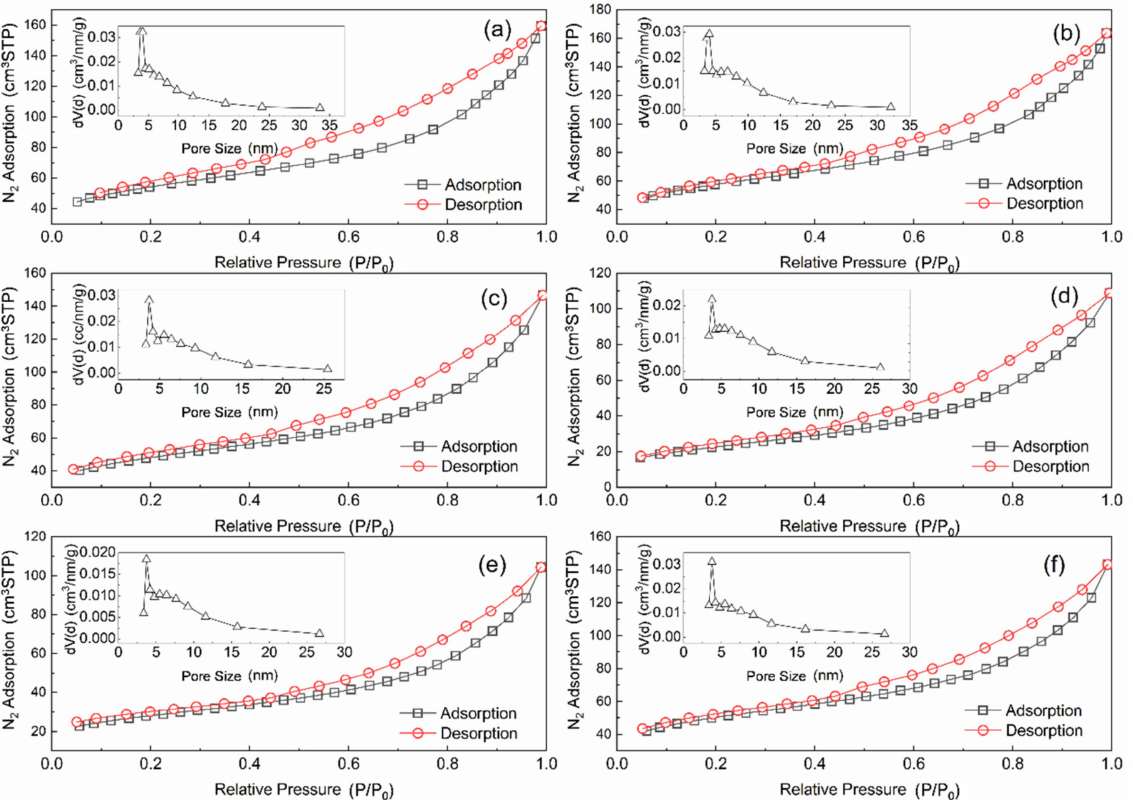
Figure 4. Nitrogen adsorption–desorption isotherm and pore size distribution of ( a ) AC, ( b ) fresh catalyst, ( c ) after deNO X , ( d ) sulfur poisoning, ( e ) thermal regeneration, and ( f ) rinsing